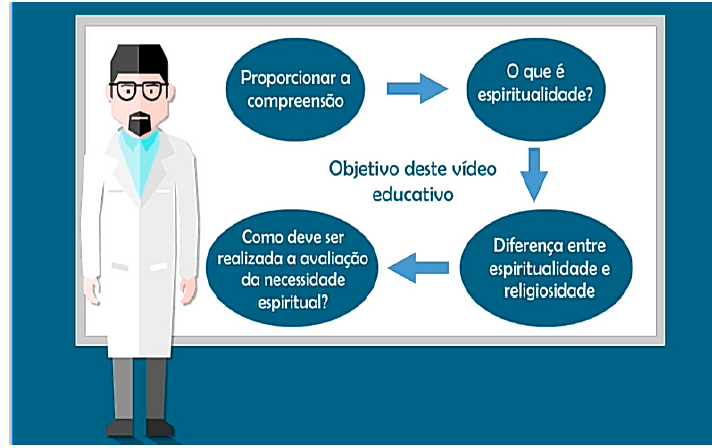
Figure 2. Theoretical aspects of the video (table content explained in English in the text).